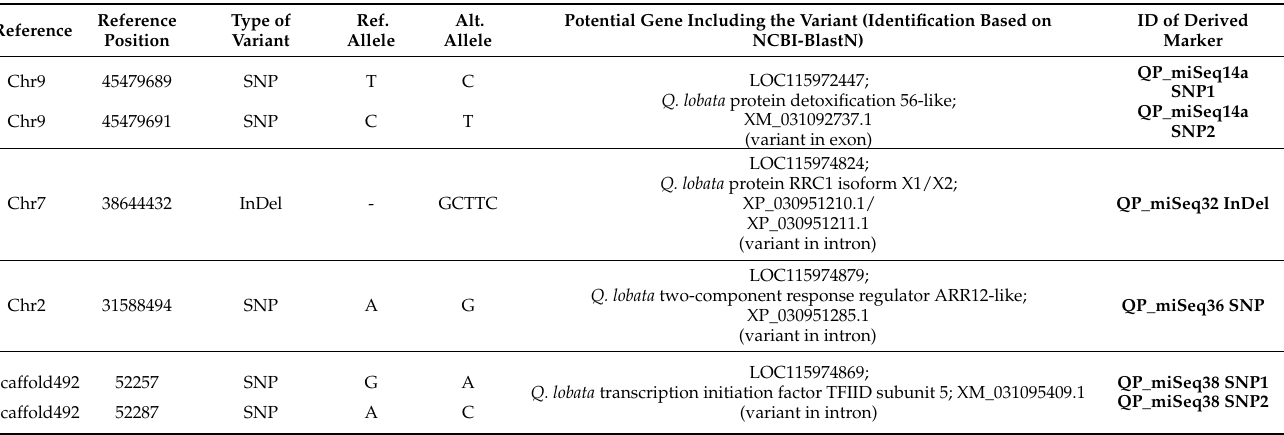
Table 2. Selected nuclear DNA sequence variants with 100% frequency difference of the alternative allele between the Q. petraea and Q. robur